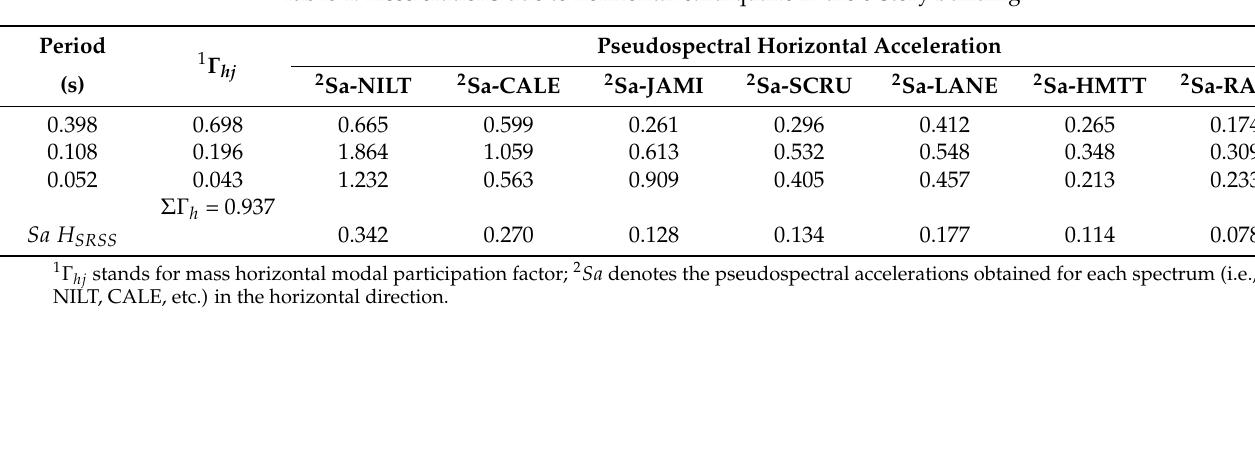
Table 4. Accelerations due to horizontal earthquake in the 6-story